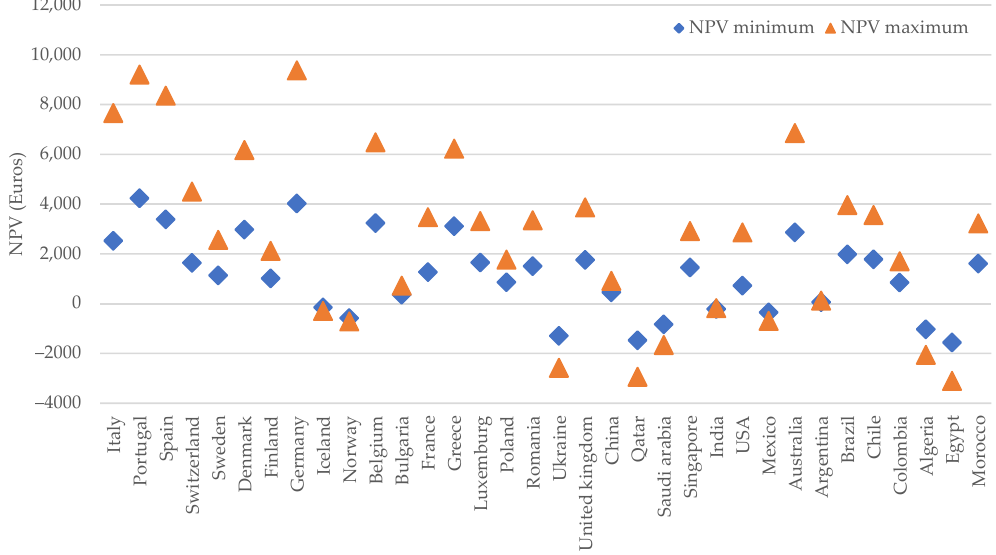
Figure 21. Country-wise NPV potential per unit collector area for financial model 1.